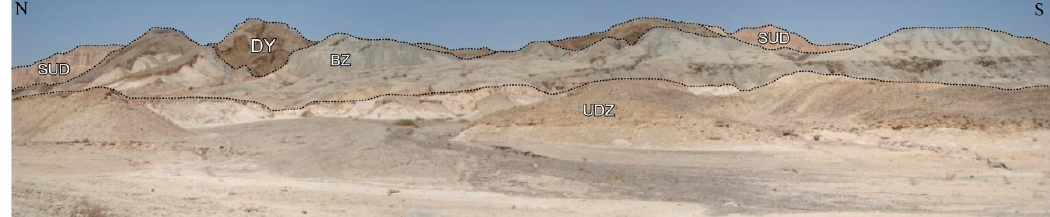
Figure 10. Panoramic view showing a N–S-trending grey-colored baked zone formed on the eastern side of the dyke cutting through the snow white-colored Sudr Chalk. (BZ: baked zone; DY: dyke, SUD: Sudr Chalk; UDZ: undisturbed zone).